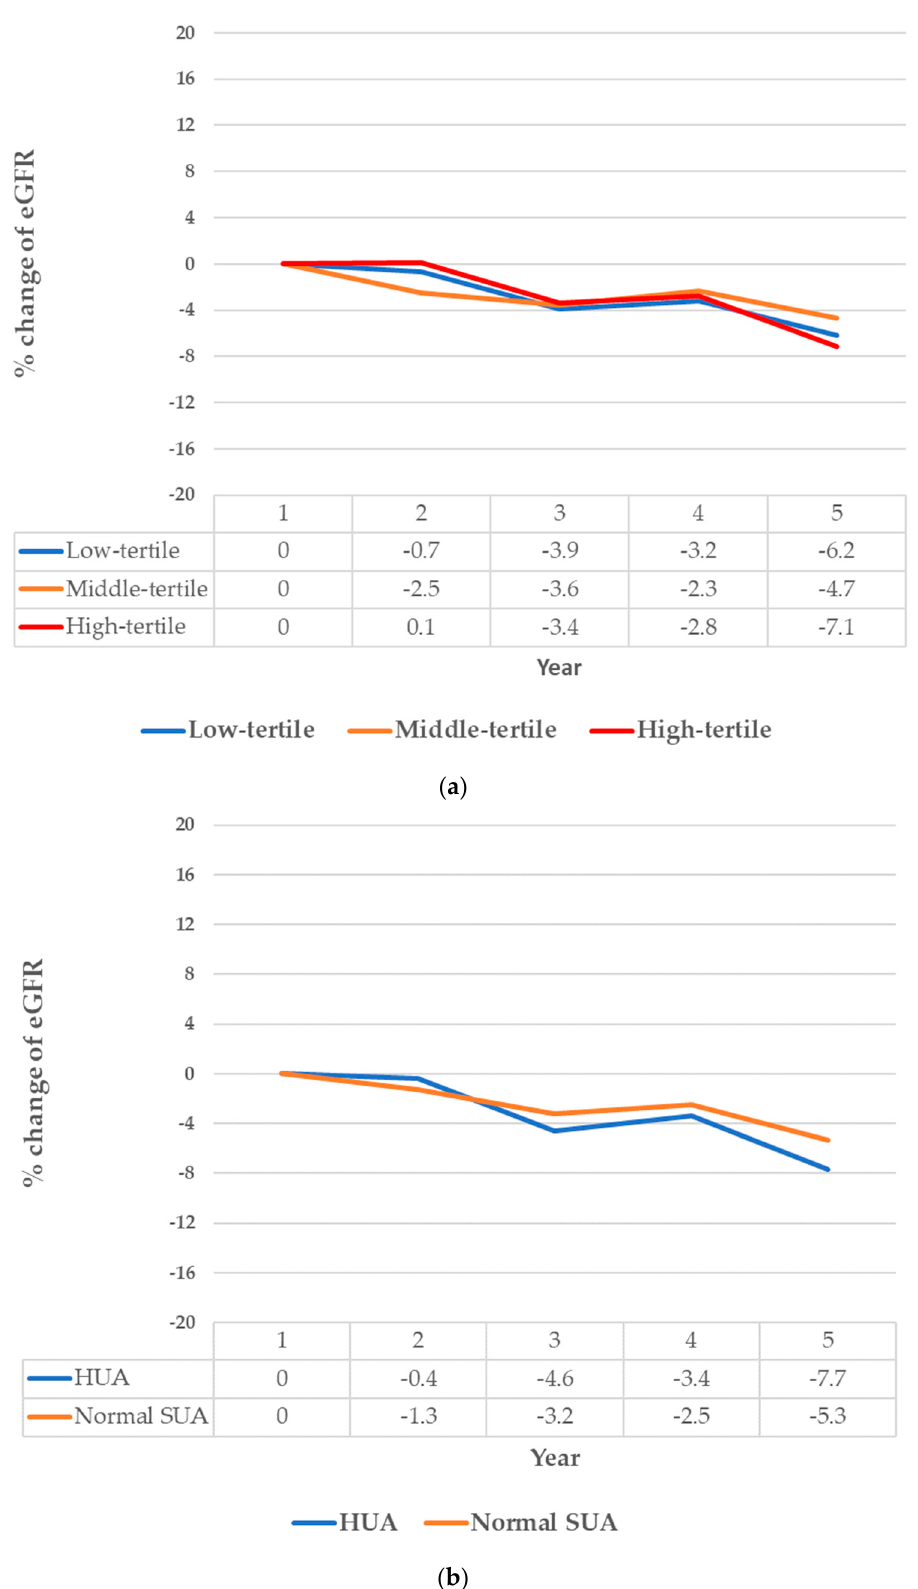
Figure 2. The decline of eGFR in five-year follow-up, stratified by tertile of serum uric acid (SUA), p = 0.327 (2 A ) and hyperuricemia, p = 0.099 (HUA) (2 B ).